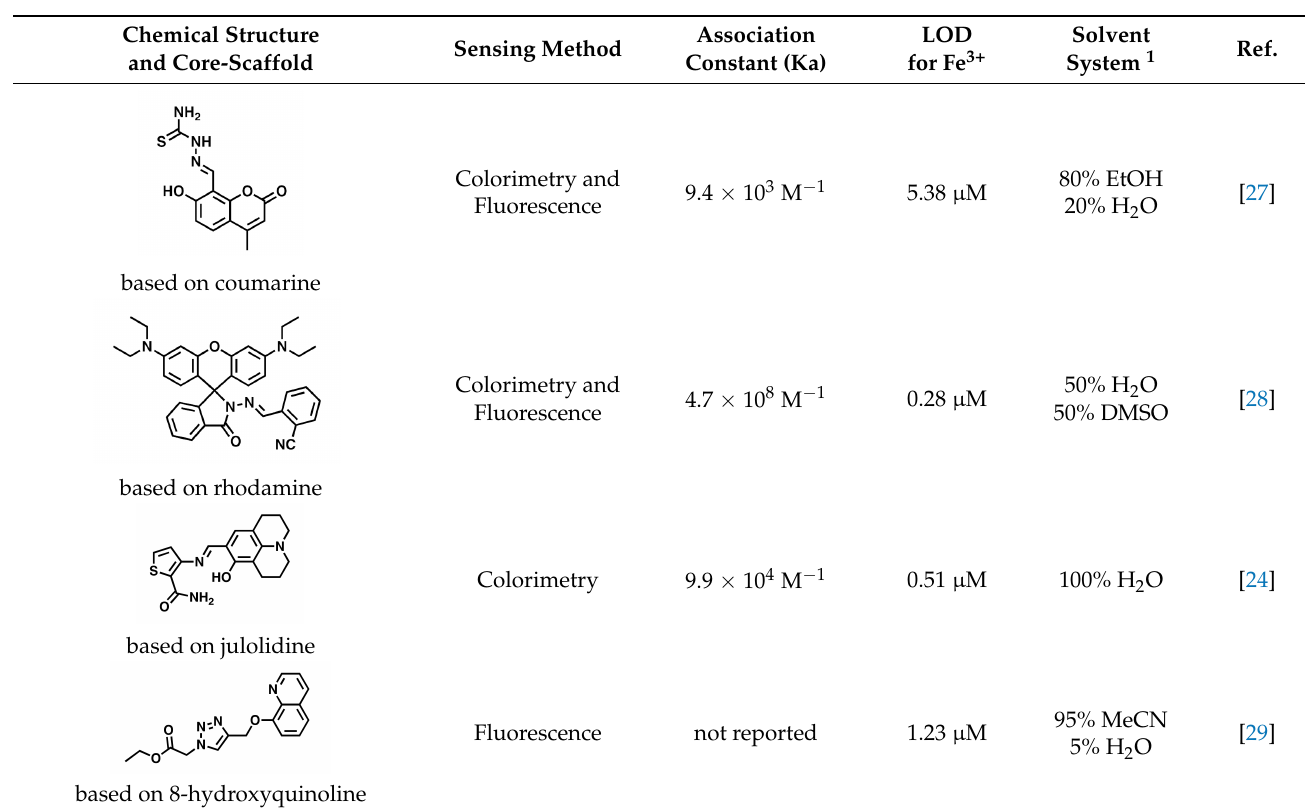
Figure S1: Emission profiles before and after addition of DMSO to 2 and HSA., Figure S2: Emission profiles of HSA upon addition of 2 used for the Stern-Volmer plot., Detailed synthetic procedures for all relevant compounds and the NMR and high-resolution MS spectra used for their